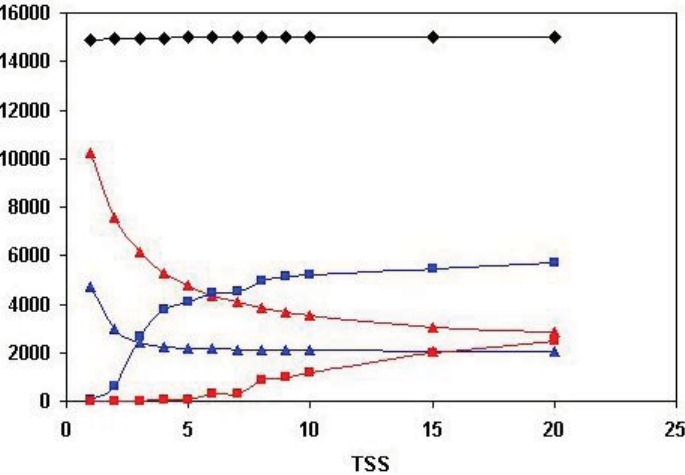
Figure 5. Analysis of sequence similarity networks of paralogous human proteins defined through all-against-all sequence comparison of human Swiss-Prot entries. The matches were ranked in the order of decreasing sequence similarity scores, including in this list only the top-scoring 1, 2, 3, .... 20 matches with e-values of <10 − 5 , excluding self-matches. Datasets containing the top-scoring one, two... twenty sequences were created (TSS = 1, TSS = 2, .... TSS = 20 datasets) and the component structure of sequence similarity networks defined for these datasets was analyzed as described in the text. The numbers on the abscissa indicate the number of top-scoring matches included in the analyses (TSS = 1, .... TSS = 20). Black diamonds represent the number of human Swiss-Prot entries with at least one significant human Swiss-Prot homolog. Blue triangles represent the number of weak components, red triangles represent the number of strong components. Blue rectangles represent the number of sequences in the Largest Connected Component of weak component analysis, red rectangles represent the number of sequences in the Largest Connected Component of strong component